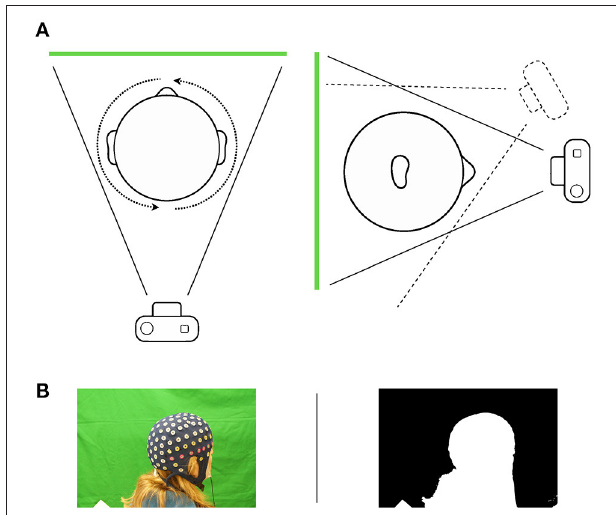
FIGURE 1 | (A) Schematic illustration of the image capturing process. The subject moves in front of a chroma key greenscreen while sitting on a swivel chair. Capturing images from different height levels ensures coverage from the top of the head. (B) A picture—mask pairing as used by Agisoft PhotoScan. Setting areas to a value of 0 masks the background, whereas the object is defined by setting respective areas to a value of